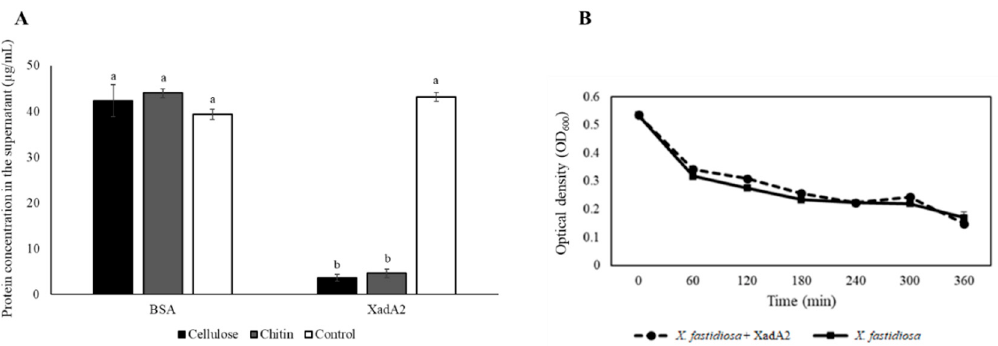
Figure 1. A ffi nity of Xylella fastidiosa XadA2 adhesin to polysaccharides and its influence on the bacterial aggregation capacity. ( A ) Mean concentration ( ± SEM, n = 6) of the synthetic XadA2 and BSA proteins remaining in the supernatant after incubation with cellulose and chitin, and with the bu ff er without polysaccharides (control). Means followed by equal letters, for each protein, did not di ff er statistically by the chi-square test ( p < 0.0001). ( B ) Mean values ( ± SEM, n = 3) of absorbance when X. fastidiosa -GFP was incubated in X. fastidiosa medium (XFM) with or without synthetic XadA2.